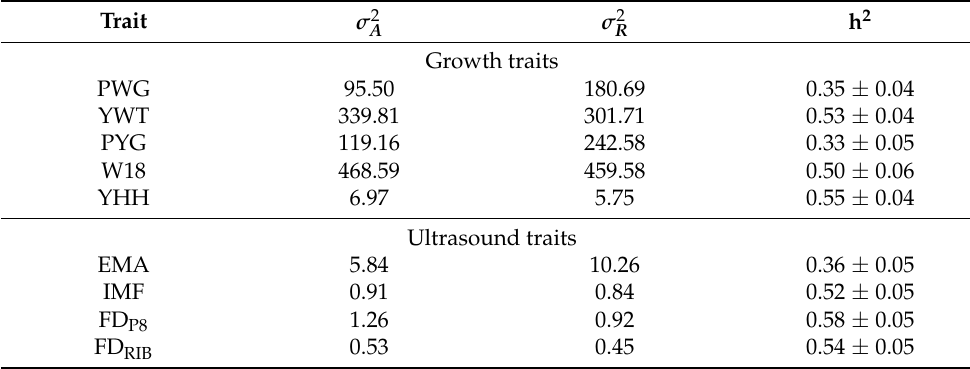
Table 4. Variance components ( σ 2 their standard errors ( ± SE) from uni- and bivariate analysis for growth, ultrasound and carcass traits in New Zealand beef